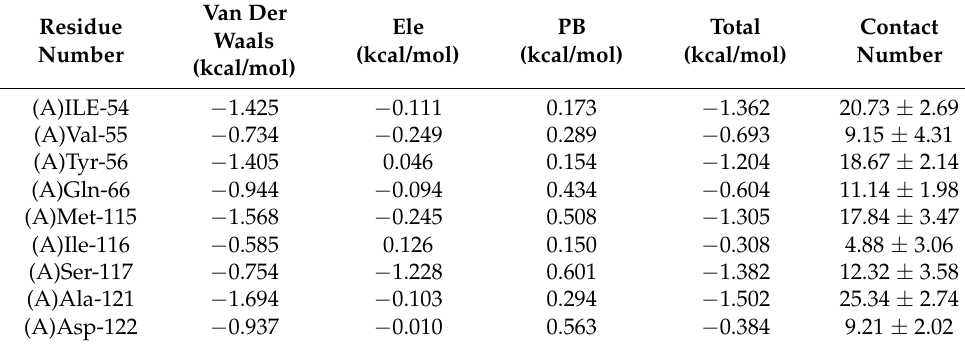
Table 6. 6-Gingerol per-residue energy